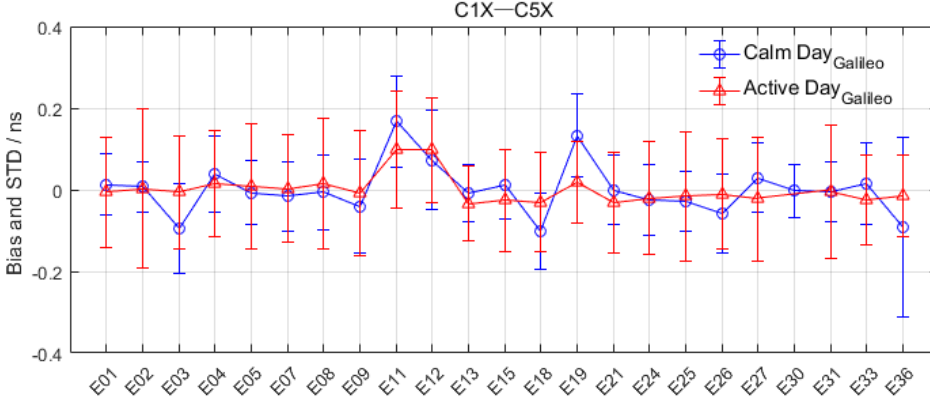
Figure 16. Comparison results between DCB and CAS products of Galileo satellites.